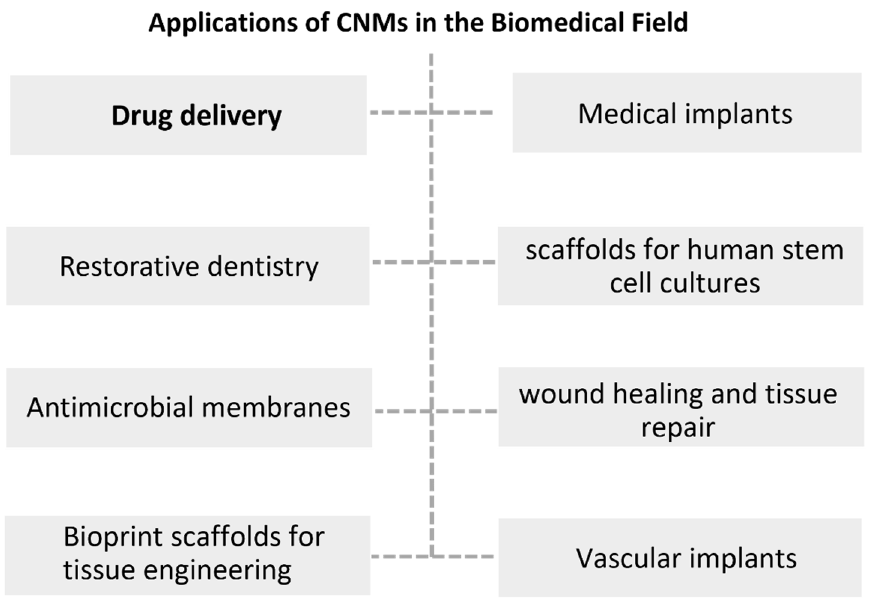
Figure 3. Potential applications of cellulose nanomaterials in biomedicine.